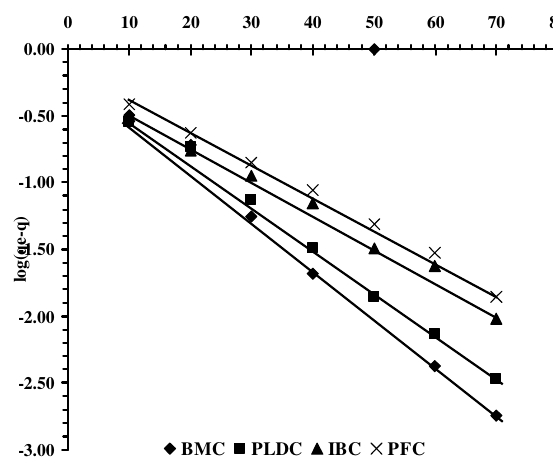
Figure 3 . Lagergren model for the removal of Mn(II)